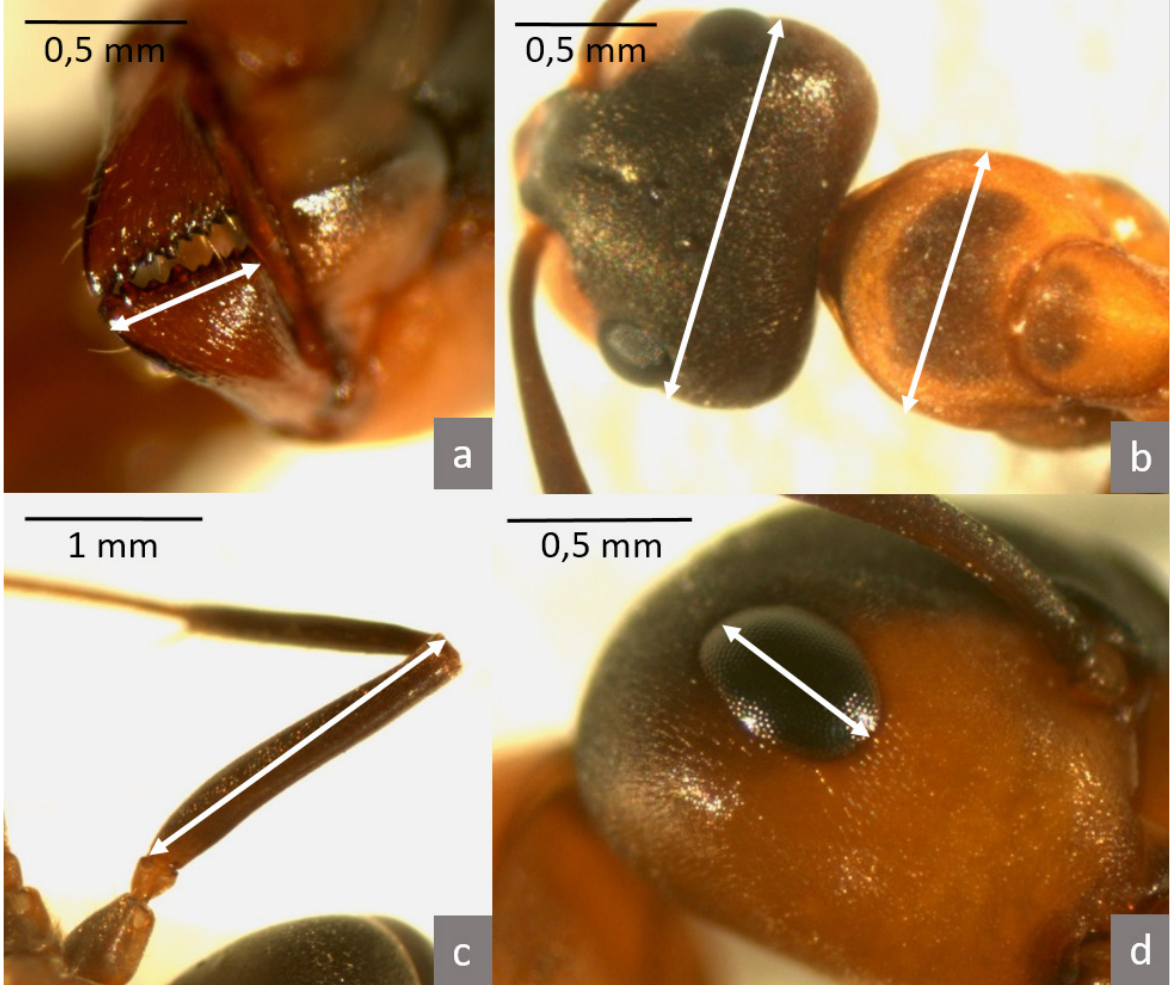
Fig 1. Measured parts of the bodies of Formica polyctena workers: a) mandible width, b) head and pronotum width, c) femur length, d) eye length. All morphological parameters measured in ants acquired at different capture points (tuna, honey, nest) were statistically significantly different (ANOVA: df = 2, p < 0.001). Body size values were highest at the nest, and individuals of somewhat smaller sizes were found on the tuna. The smallest parameters were those of individuals on the honey bait. These differences were statistically significant in all cases (contrast: p < 0.001, Fig